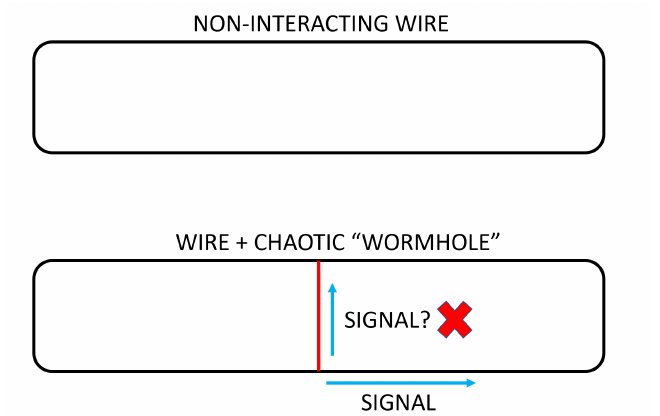
Figure 1 . A simplified version of chaos-protected locality. In the upper diagram, energy and information can only propagate from bottom to top the long way around. In the lower diagram, there are now in principle two routes that can be taken from bottom to top, but if the short-cut is chaotic, then it will not transmit any simple signal. Hence, if the original simple wire does host long-lived excitations, then the time needed to locally signal from bottom to top is still set by the length of the simple wire, despite the